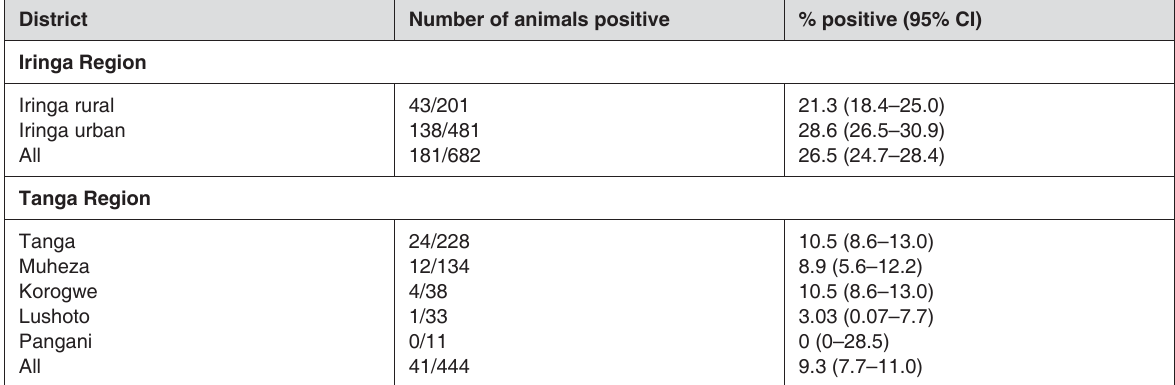
TABLE 2 The prevalence of Cryptosporidium spp. in dairy cattle by regions and districts in Iringa and Tanga. 95 % CI = confidence intervals adjusted for the farm effect